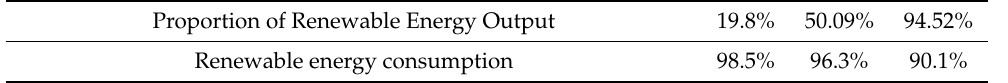
Table 2. Renewable energy